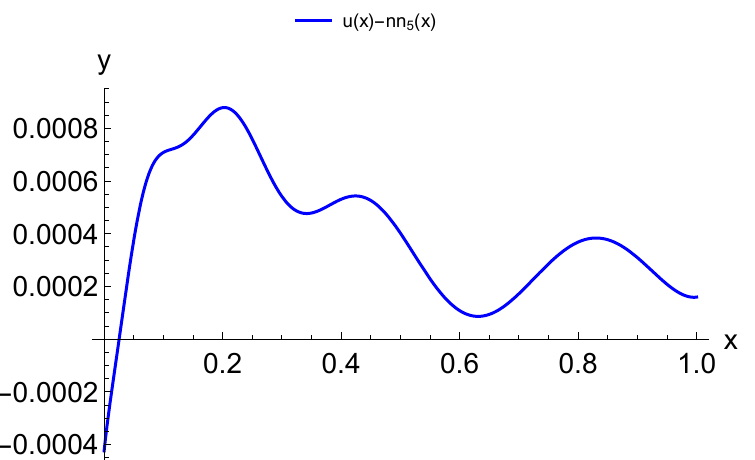
Figure 2. Plot of the error of neural network solution nn 5 ( x ) (9) (number of hidden layer neurons n = 5, Gaussian activation functions) as applied to problem (30) (parameter value s = 0.1). The training loss history is shown in Figure 3.